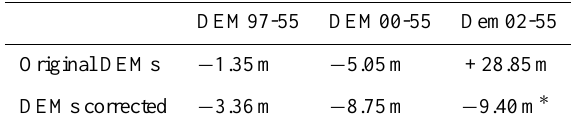
Table 7. Altitude changes on glaciated areas on original and corrected